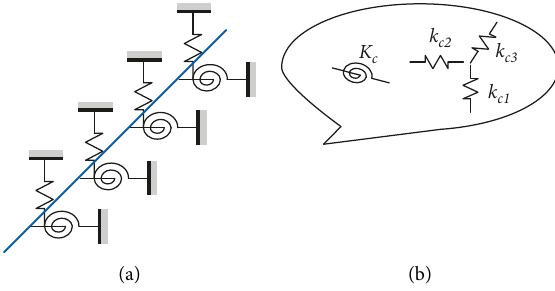
Figure 2: Boundary spring and coupled spring at: (a) the boundary position and (b) the coupled